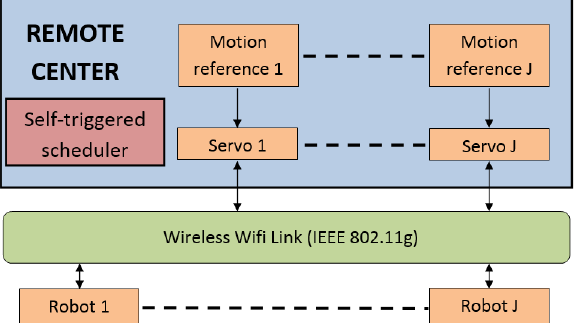
Figure 5. Global structure of the adaptive self-triggered strategy implemented for multiple robots that are remotely